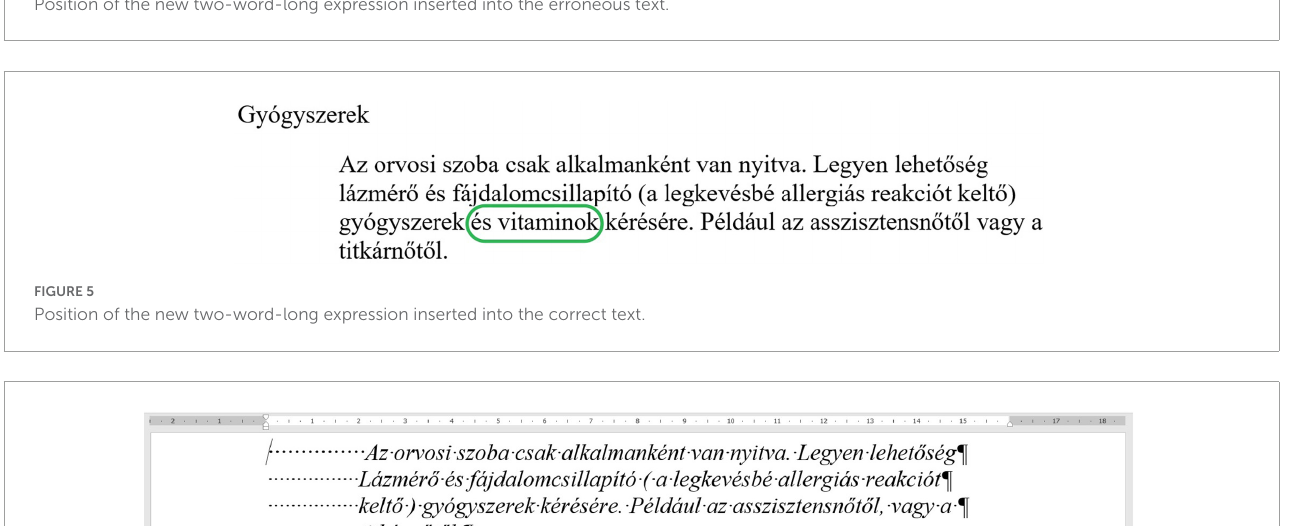
FIGURE4 Position of the new two-word-long expression inserted into the erroneous text.